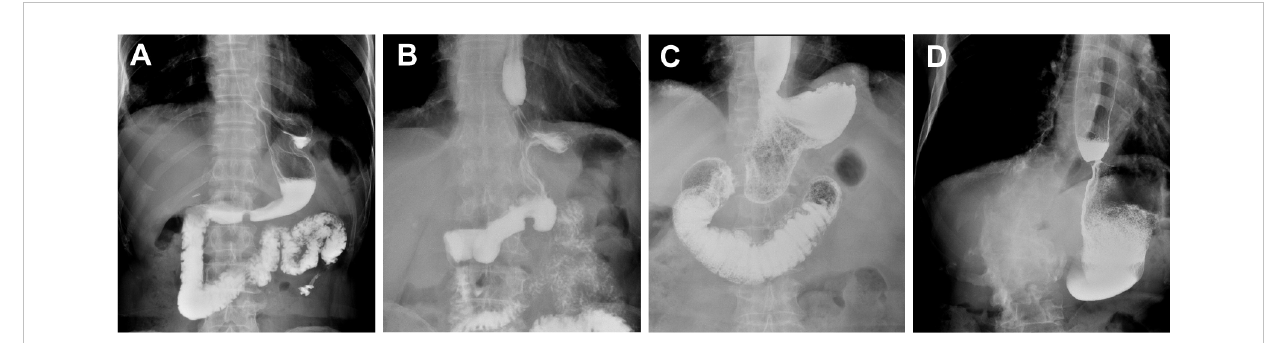
FIGURE 3 Typical contrast images of the upper digestive tract. (A) Upper digestive tract contrast images of normal tubular esophagogastric anastomosis; (B) Upper digestive tract contrast images for patients with anastomotic of stenosis tubular esophagogastric anastomosis; (C) Upper digestive tract contrast images of normal traditional esophagogastrostomy; (D) Upper digestive tract contrast images for patients with anastomotic stenosis of traditional